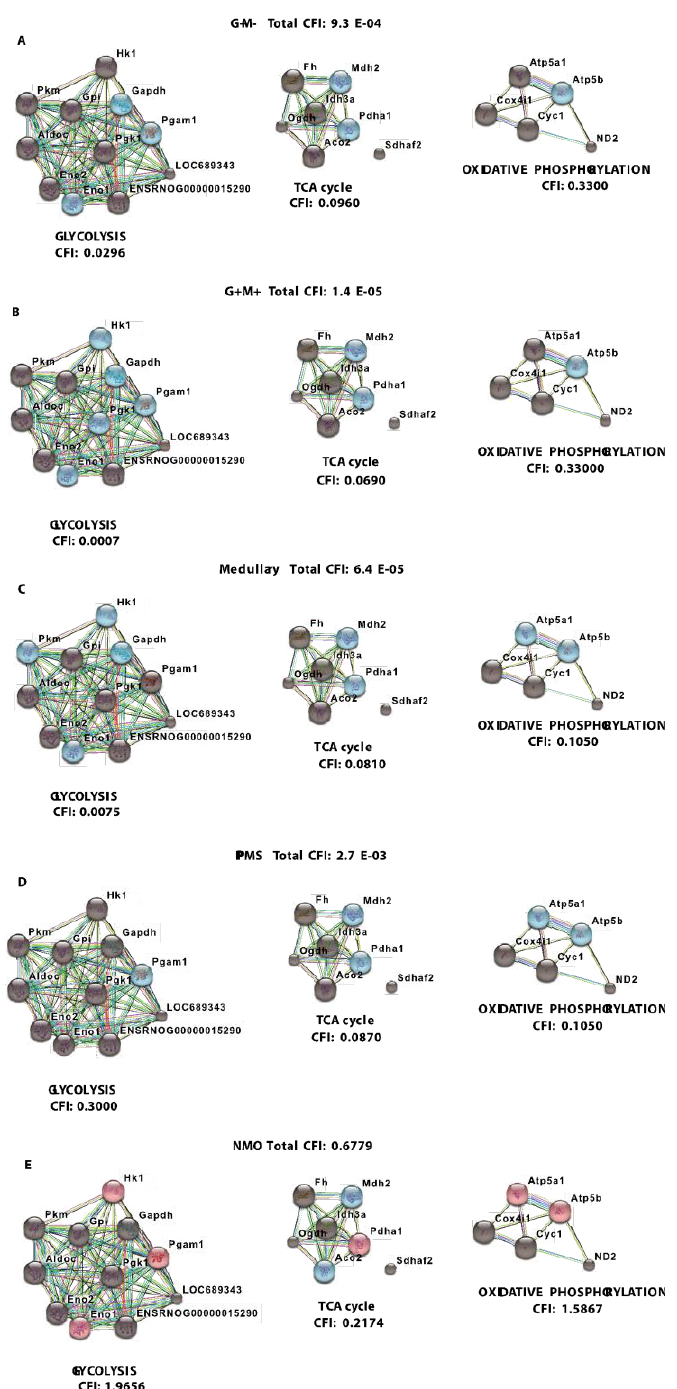
Figure 6. Visualization of gene interaction network generated by STRING v10. Visualization of gene interaction network generated by STRING v10 in CGNs cultures exposed to CSF from patients with ( A ) G+/M− RMS; ( B ) G+/M+ RMS; ( C ) Spinal MS (Med); ( D ) PPMS; ( E ) NMO. Different line colors represent the types of evidence for the association between genes involved in glycolysis, TCA cycle and oxidative phosphorylation in neurons; Red color signifies upregulated expression, blue color signifies downregulated expression and grey color signifies genes with no variation in expression in our experimental conditions. LOC689343 signifies the Pk gene and ENSRNOG00000015290 (a specific nomenclature gave by the program) signifies the Tpi gene.